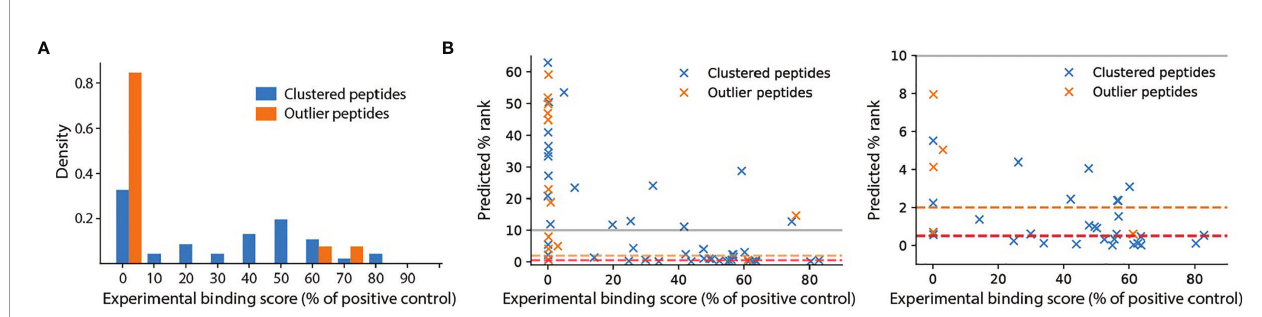
FIGURE 3 | HLA binding assay for HLA-B*14:02. Peptide synthesis and binding assay were performed by ProImmune, Ltd. (see Methods). (A) Distributions of binding scores, measured as the percentages of the binding activity compared to a positive control, for clustered peptides (n = 46) and outlier peptides (n = 13). (B) Comparison of predicted percentage ranks of eluted ligand (% rank) and binding scores. The orange and red dashed lines indicate the 2% rank and 0.5% rank thresholds for weak and strong binders, respectively. The left panel shows the full range of % rank while the right panel shows the zoomed-in at % rank